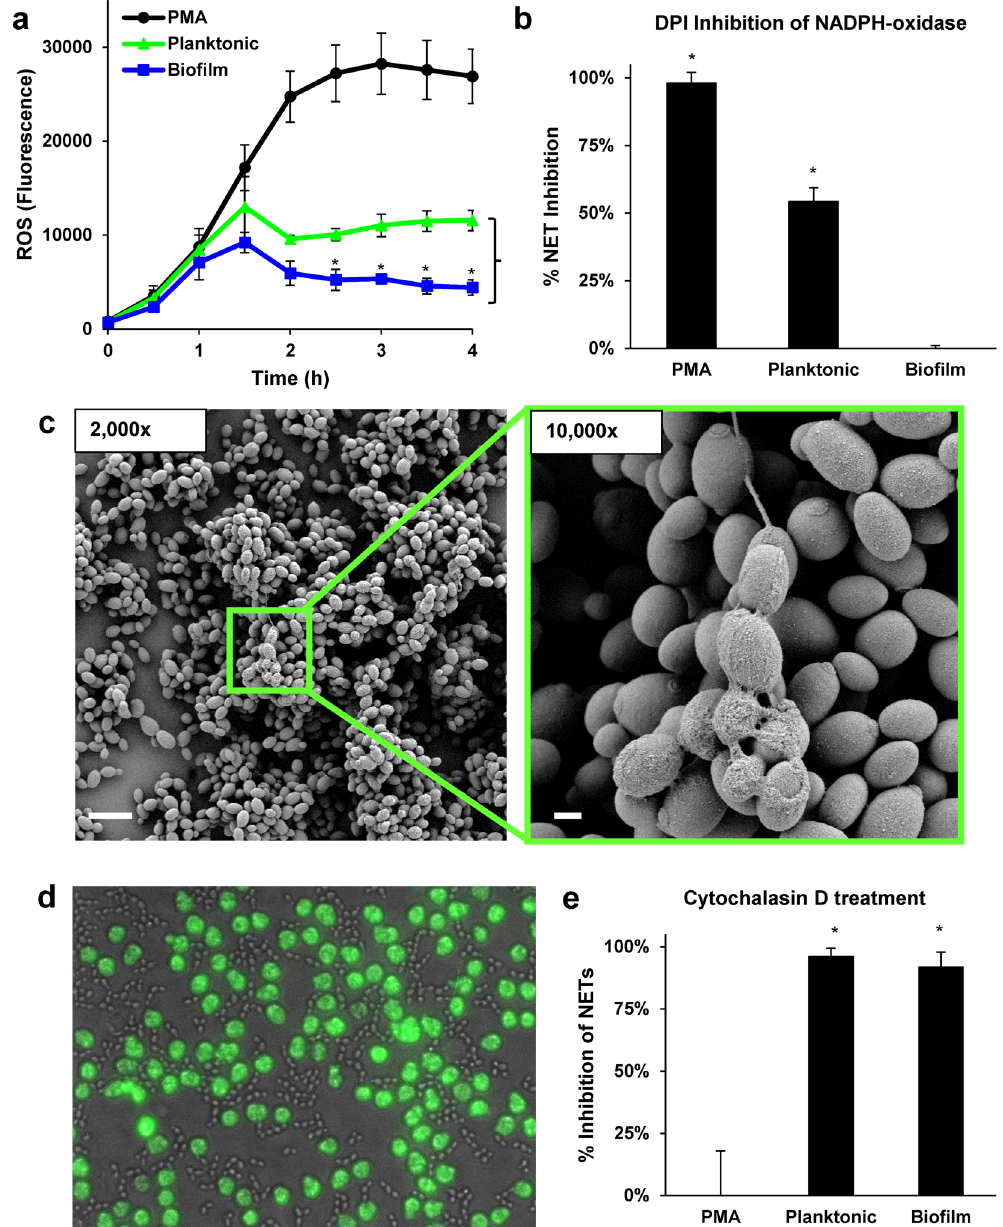
Figure 5. Mechanism of NET induction by planktonic and biofilm C . glabrata . ( a ) Production of ROS in response to C . glabrata was measured by fluorescence after neutrophils were pre-stained with oxidative stress indicator CM-H2DCFDA and co-cultured with C . glabrata over 4 h. The mean and SEM of 4 experiments performed in triplicate is shown. The statistical significance neutrophil production of ROS in response to biofilm and planktonic C . glabrata were calculated for each time point using a two-tailed Student’s t-test assuming unequal variances, * P < 0 . 05 , SEM shown . ( b ) Neutrophils were treated with DPI to inhibit NADPH- oxidase and the release of NETs in response to C . glabrata was measured by Sytox Green. The percent of the total free DNA (untreated) reduced by DPI-treatment for each condition is shown. Data represent 5 experiments performed in triplicate. Statistical significance was determined using a Student’s t-test compared to no inhibition, * P < 0 . 05 , SEM shown . ( c ) Neutrophil- C . glabrata interactions after 4 h were imaged with scanning electron microscopy. ( d ) Calcein AM-labeled neutrophils (green) were treated with cytochalasin D to inhibit phagocytosis and added to planktonic C . glabrata . Neutrophil interactions were imaged at 1 h (40x). ( e ) Neutrophils were treated with cytochalasin D to inhibit phagocytosis and the release of NETs in response to C . glabrata was measured by Sytox Green. The percent of the total free DNA (untreated) reduced by DPI treatment for each condition is shown. Data represent 5 experiments performed in triplicate. Statistical significance was determined using a Student’s t-test compared to no inhibition, * P < 0 . 05 , SEM shown